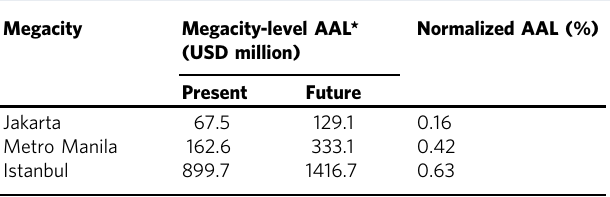
Fig. 2 Dynamics in wealth (billion USD in 2016/2018 prices) exposed to different MMI levels for 10 and 2% probabilities of exceedance in 50 years. a Jakarta, b Metro Manila, and c Istanbul. Table 1 Megacity-level AAL values corresponding to present and